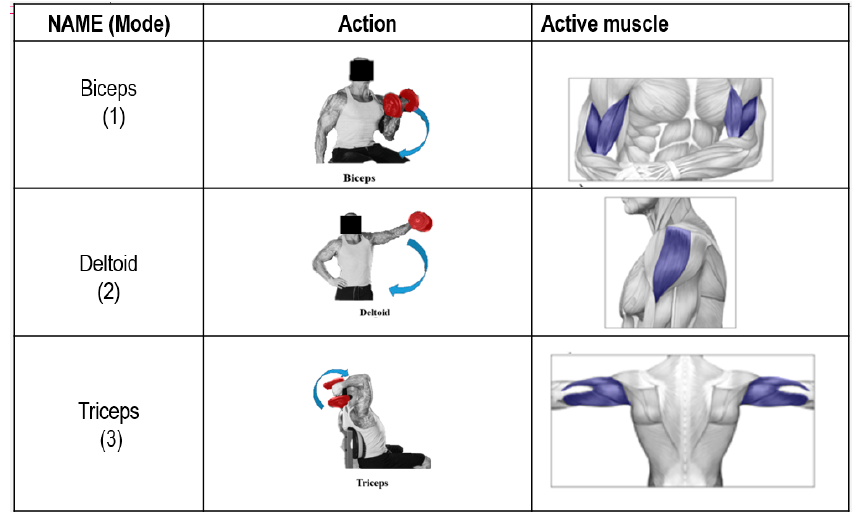
Figure 2. Three simple modes and groups of muscles in dumbbell training.